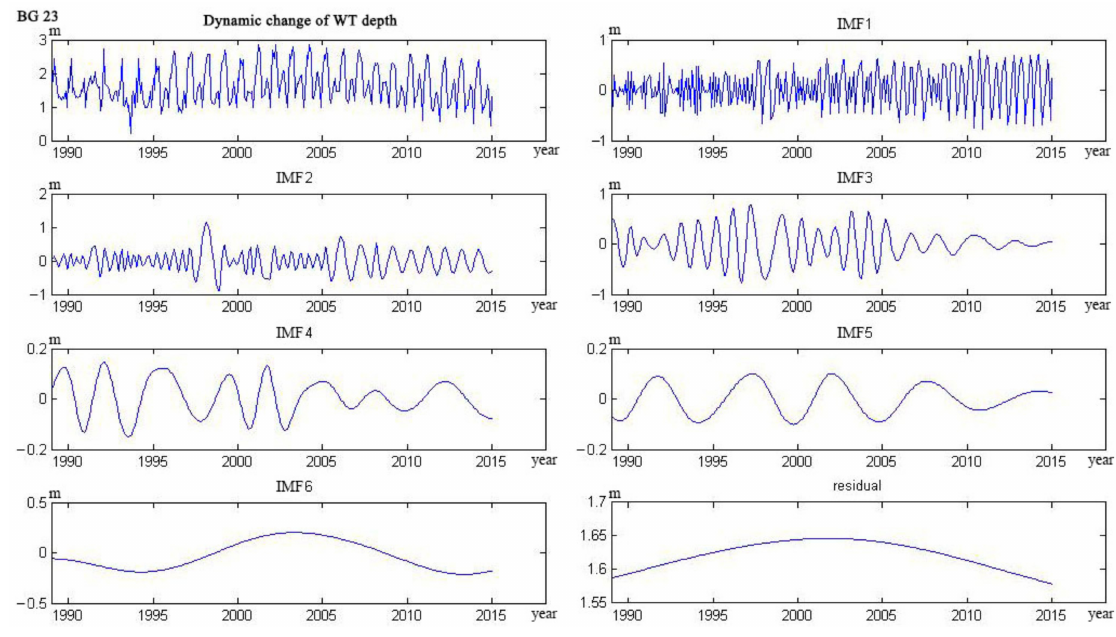
Figure A15. Decomposition of groundwater time series data of well BG23.